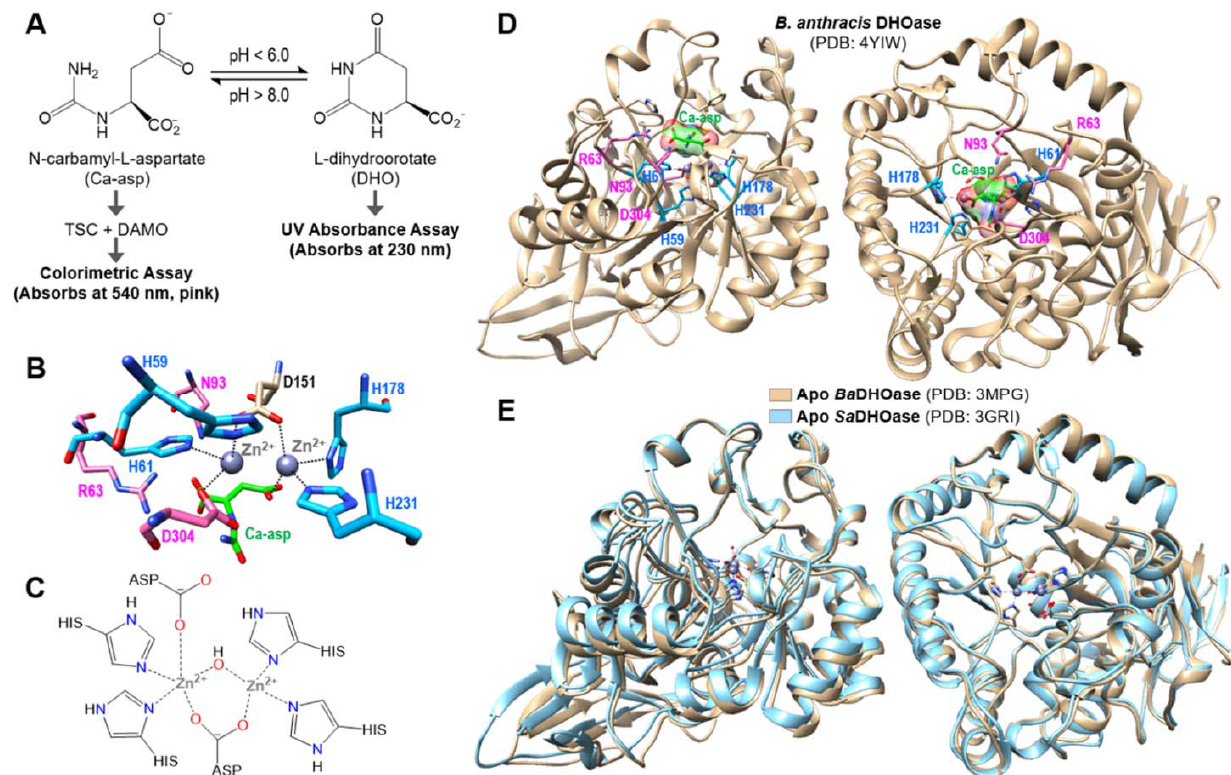
Figure 1. Background information. ( A ) The pH-dependent, reversible cyclization of N-carbamyl-L-aspartate (Ca-asp) to L-dihydroorotate (DHO) catalyzed by DHOase. Two assays to detect Ca-asp and DHO. ( B ) Dimeric structure of Bacillus anthracis DHOase complex with Ca-asp (PDB: 4YIW). The Ca-asp and three catalytic residues (R63, N93 and D304) are shown in green and pink, respectively. Four zinc-binding histidines are in blue. ( C ) The active site of Class I DHOase displaying two inequivalent Zn (II) ions. ( D ) The active site of B. anthracis DHOase with Ca-asp bound (PDB: 4YIW). The Ca-asp and three catalytic residues (R63, N93 and D304) are shown in green and pink, respectively. Four zinc-binding histidines are in blue. ( E ) Overlaid structures of apo DHOases from B. anthracis and S. aureus . Apo Ba DHOase and Sa DHOase are shown in tan and cyan, respectively.